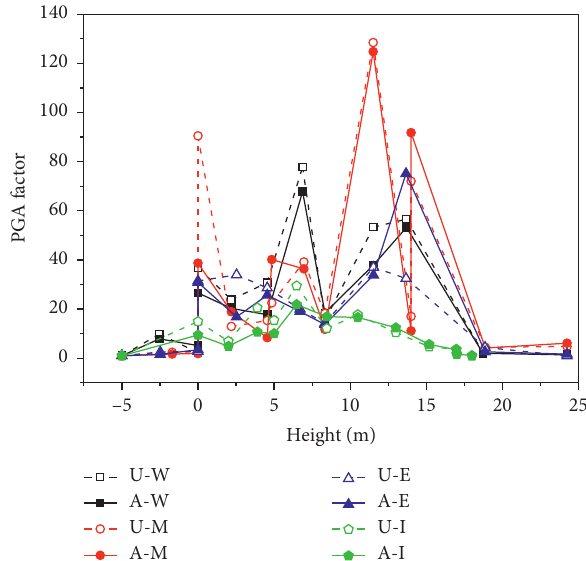
Figure 12: PGA amplification factor at different monitoring points of the anchorage and original cliff